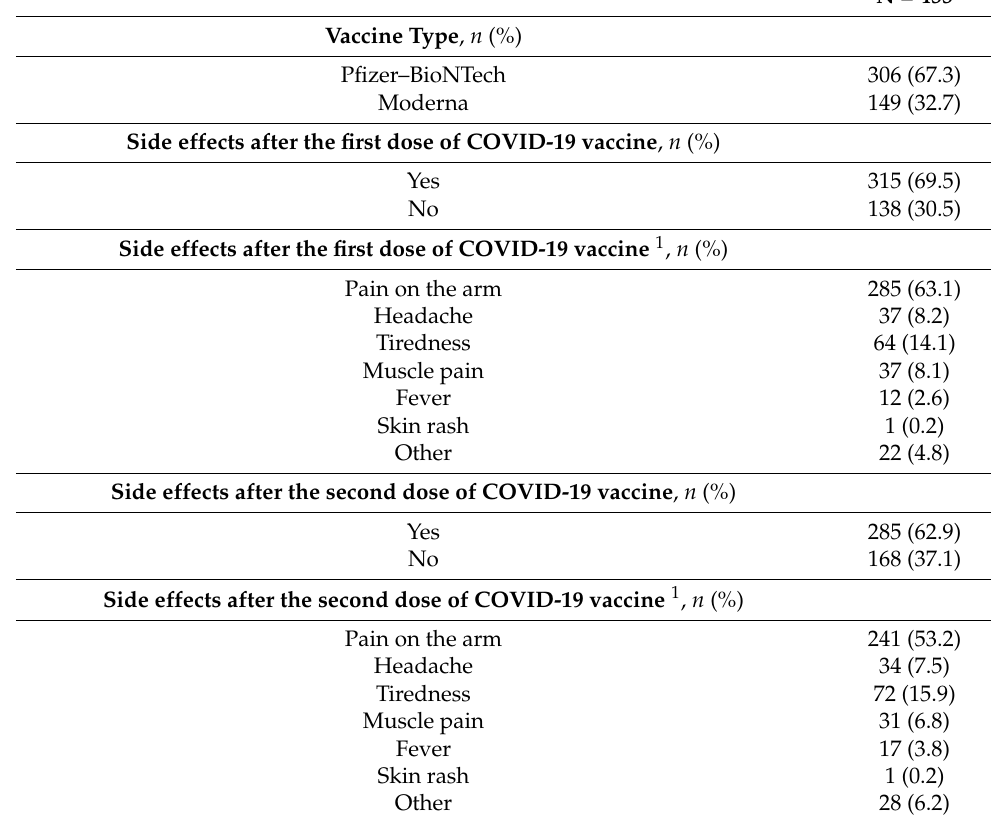
Table 2. Vaccine type and vaccination status of the study